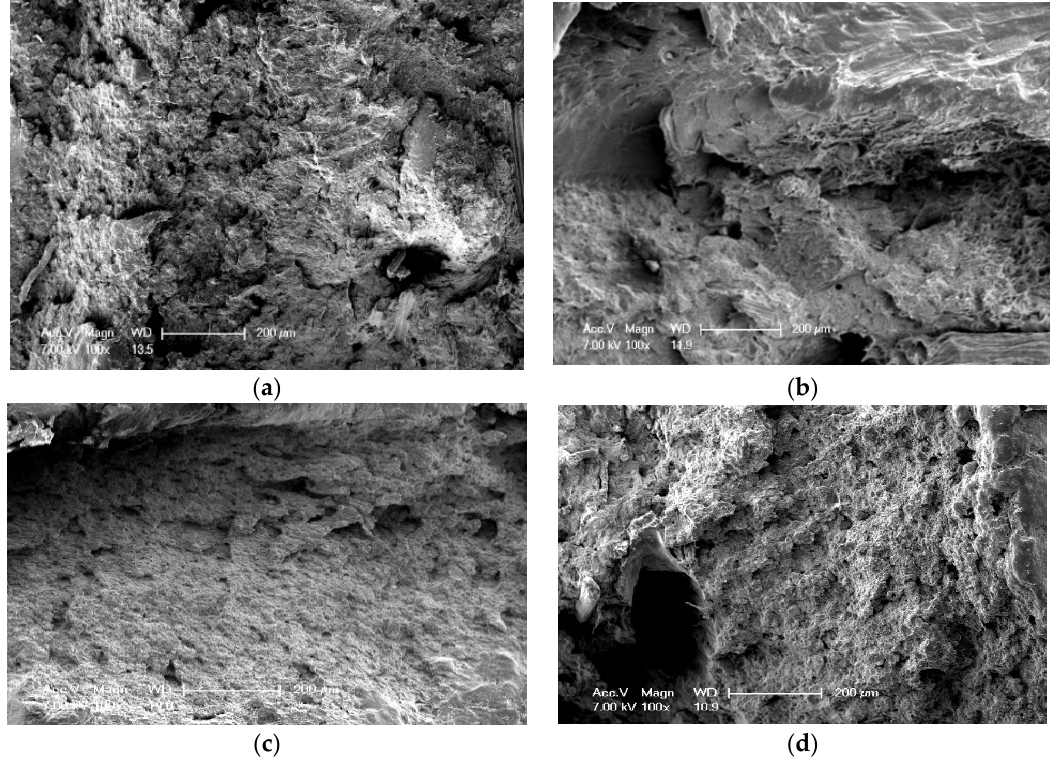
Figure 6. Microstructure of fracture surfaces of BPCs specimen: ( a ) containing 0% of BPF; ( b ) containing 6% of WM; ( c ) containing 10% of WM; ( d ) containing 14% of WM.